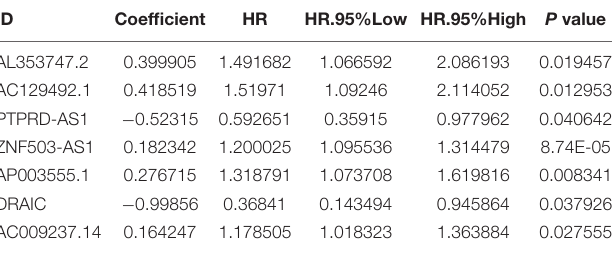
TABLE 1 | Multivariate Cox regression analysis of the seven lncRNAs in lncRNA